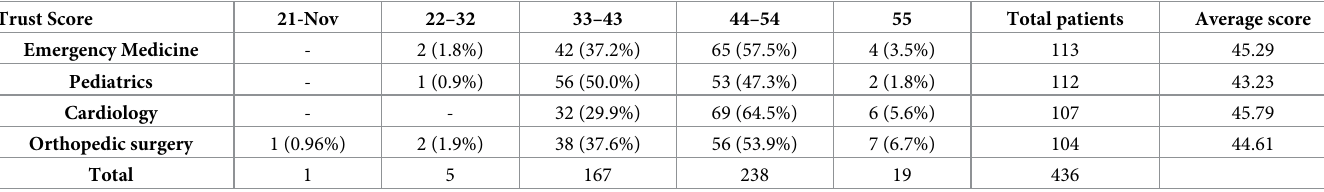
Table 2. Trust score by